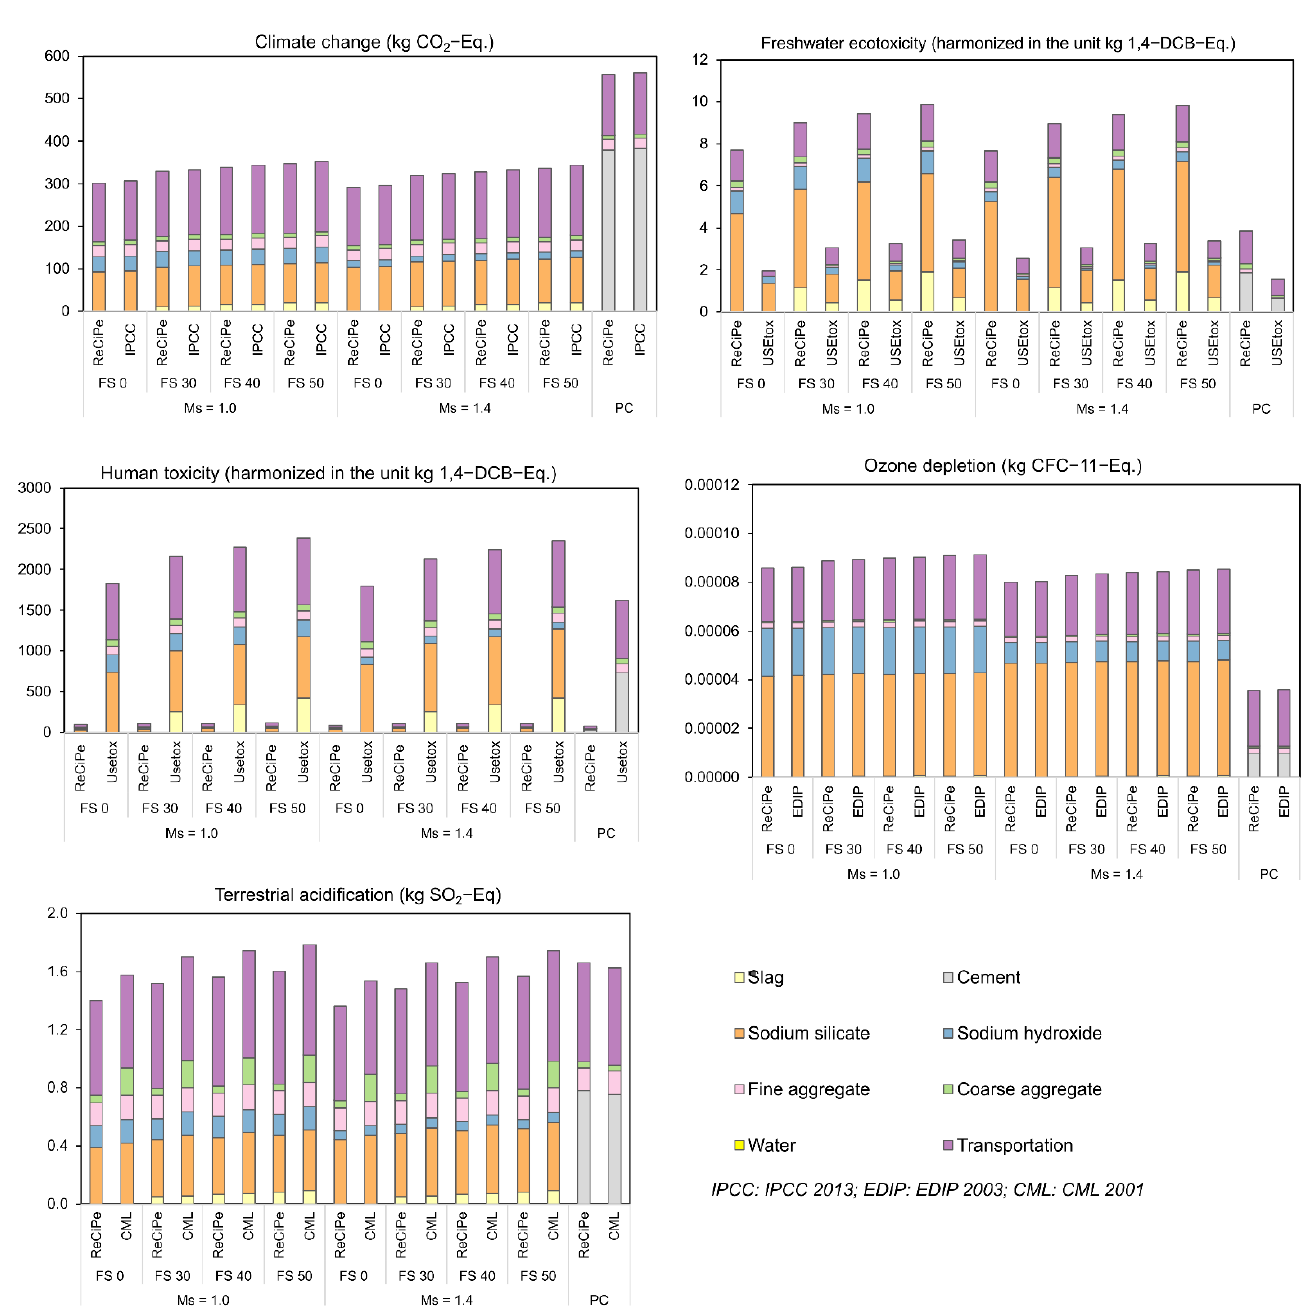
Figure 30. Comparison of environmental impacts using ILCD default methods.